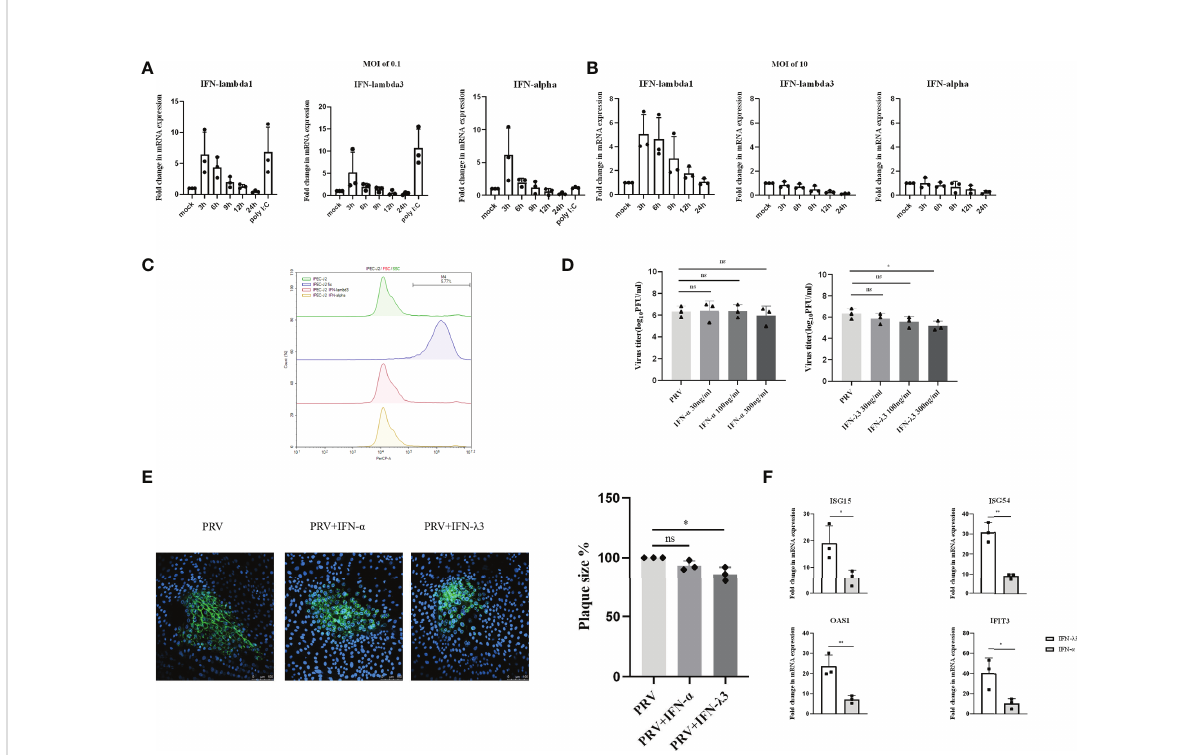
FIGURE 3 Expression and antiviral effect of type I and type III IFNs in response to PRV infection in IPEC-J2 cells. IPEC-J2 cells were inoculated (A) low dose PRV (MOI of 0.1PFU/cell) or (B) high dose PRV (MOI of 10PFU/cell). At different time points post inoculation, cell lysates were prepared for RT-qPCR analysis of expression of porcine IFN- a , IFN- l 1 and IFN- l 3. (C) IPEC-J2 cells were treated with IFN- a or IFN- l 3 (300ng/ml) for 24 h, followed by PI staining and fl ow cytometric analysis to assess cell viability. (D) IPEC-J2 were pretreated with recombinant porcine IFN- l 3